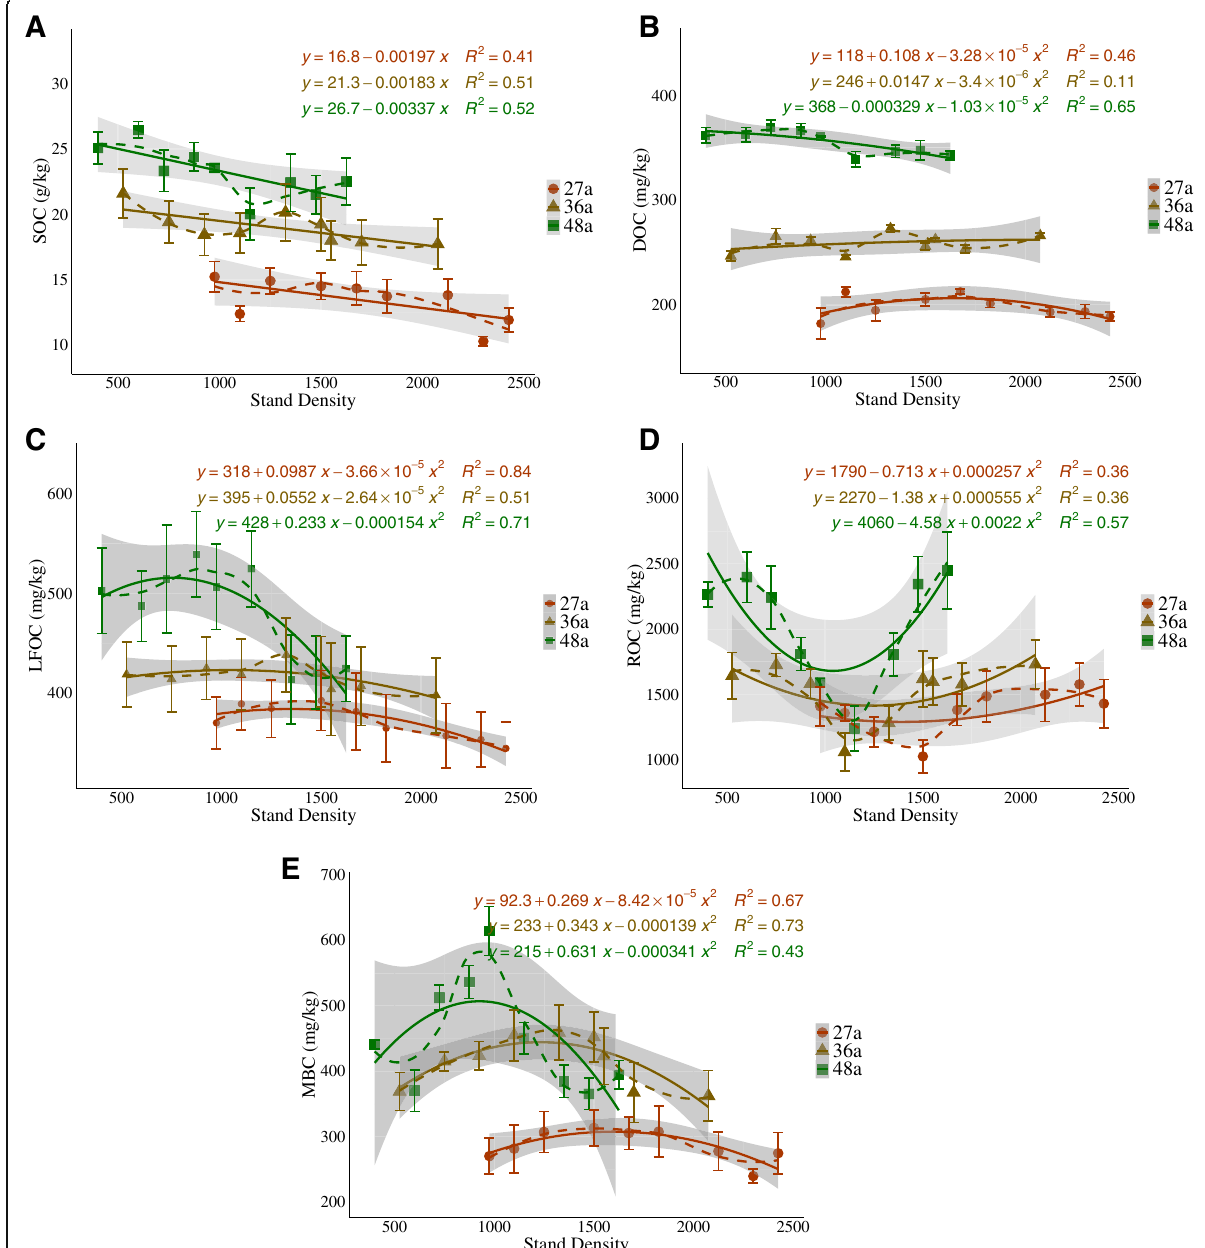
Fig. 5 Variation of SOC and soil labile organic carbon with stand density in different aged stands. Error bars show the standard deviation (SD). Shaded areas represent the confidence intervals. SOC, soil organic carbon; DOC, soil dissolved organic carbon; MBC, microbial biomass carbon; LFOC, light fraction organic carbon; ROC, readily oxidized carbon. 27a, 27-year-old stand; 36a, 36-year-old stand; 48a, 48-year-old